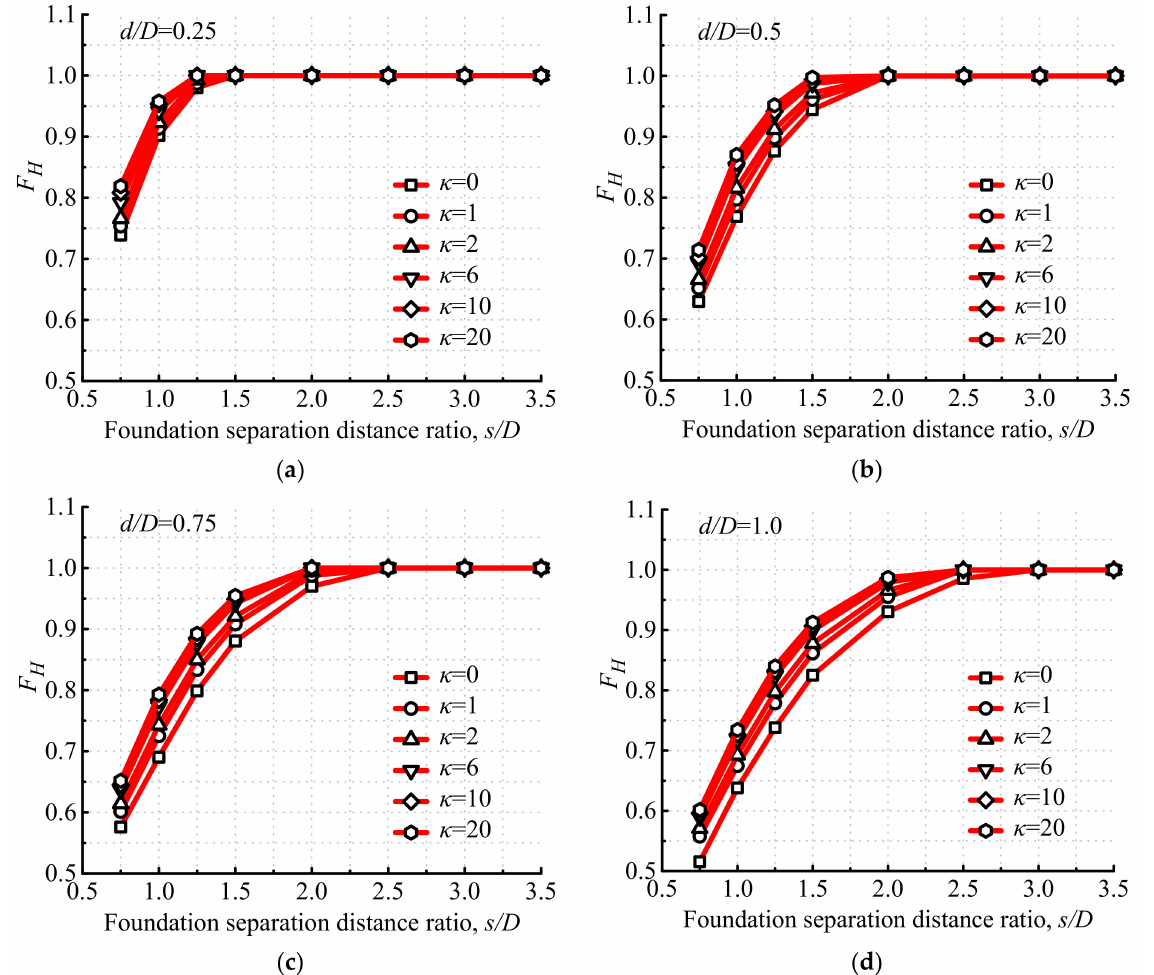
Figure 12. Normalized horizontal group effect factors of tetrapod bucket foundations under various